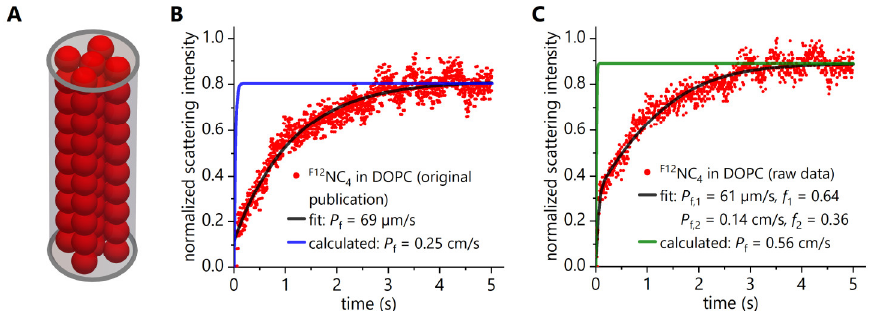
Figure 5. ( A ) Schematic illustration of the hypothetical case in which the 0.9-nm wide F12 NC 4 nanochannel accommodates five independent single-file water columns. ( B ) Analysis of the ex- emplarily depicted stopped-flow light scattering trace (ref. [10], Figure S38) obtained for DOPC liposomes with diameter d = 200 nm ( d was taken from page 7 of the Suppl. to ref. [10]) in the presence of 0.0053 mol% F12 NR 4 . For digitization (red points) we used WebPlotDigitizer. We found vesicle volume V ( t ) as a function of time and fitted Equation (9) to V ( t ) (black trace), resulting in P f = 69 µm/s. As Itoh et al. claimed that F12 NC 4 increases P f to ≈0.25 cm/s (read from ref. [10], Figure S38C), we show a calcu- lated curve with this permeability in blue. ( C ) Plotting the raw data (DOI: 10.5061/dryad.h18931zq1) reveals two events with different kinetics. At first, we assumed the presence of two vesicle popula- tions (where f 1 and f 2 indicate the relative size of their fractions) with d = 176.1 nm (DOI: 10.5061/dryad.h18931zq1) possessing permeabilities P f,1 and P f,2 . The inset states the results of the fitting procedure [14], revealing a major fraction of empty DOPC vesicles. If each vesicle contains at least one channel with p f = 5.5 × 10 −10 cm 3 s −1 , deflation kinetics resembling the green line should be expected. The genesis of the minor fraction with fast kinetic is unclear. Itoh et al. assigned the fast component to P f,c and the slow component to P f,l . Taken together, the authors claim a scenario like in Figure 2D where Mickey Mouse ears miraculously plug the channel after only a few ms. Such a scenario is implausible, since F12 NC 4 does not possess an intrinsic blocking mechanism.